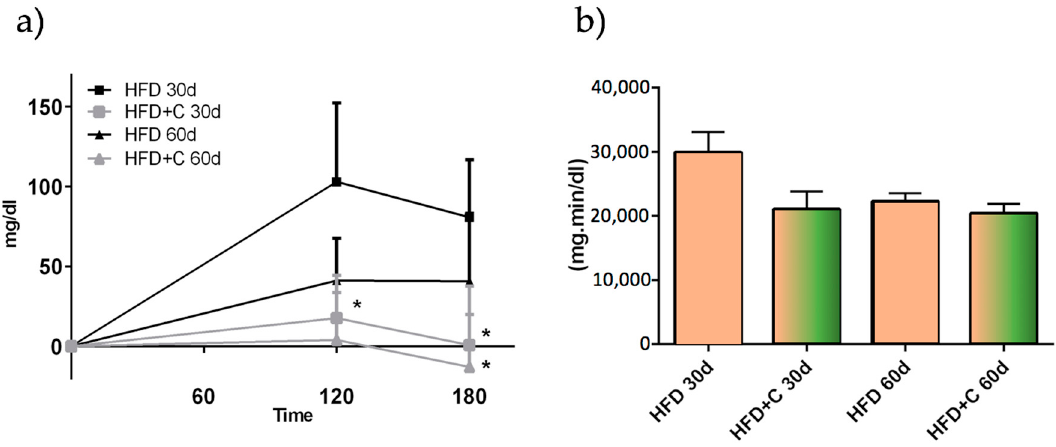
Figure 5. ( a ) Plasma TAG kinetic curve comparison between HFD (black square) and HFD + C (grey triangle) during the experimental study trial. The values were expressed as increment from basal TAG values (TAG mg/dL increment mean ± SD, n = 6). Stars indicate that the values were significantly different ( p < 0.05 with *); ( b ) Area under the curve (AUC) of the experimental groups at different point of times.